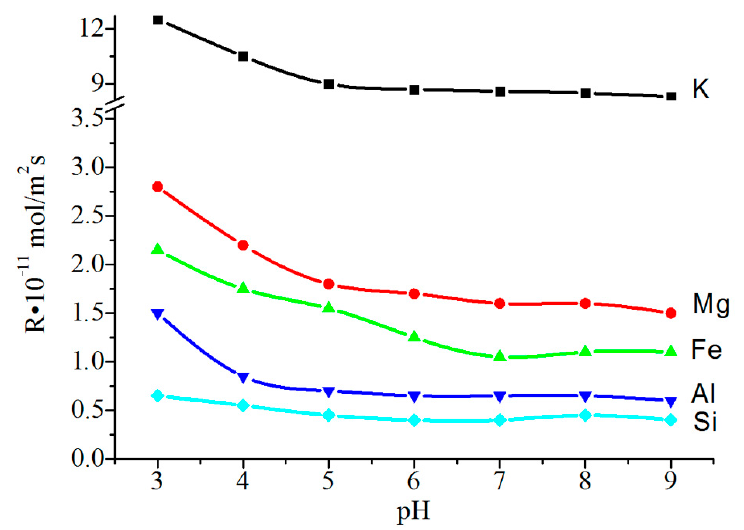
Figure 7. The initial rate of leaching of cations from phlogopite in the range of pH